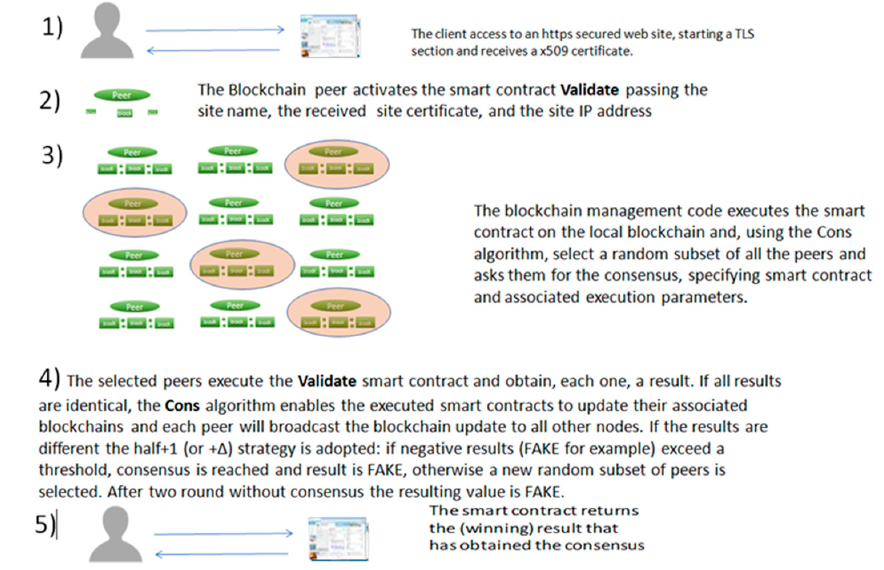
Figure 1. Explanation of the Cons algorithm. The size and the selection procedure of the subset of peers are crucial steps in our proposal.